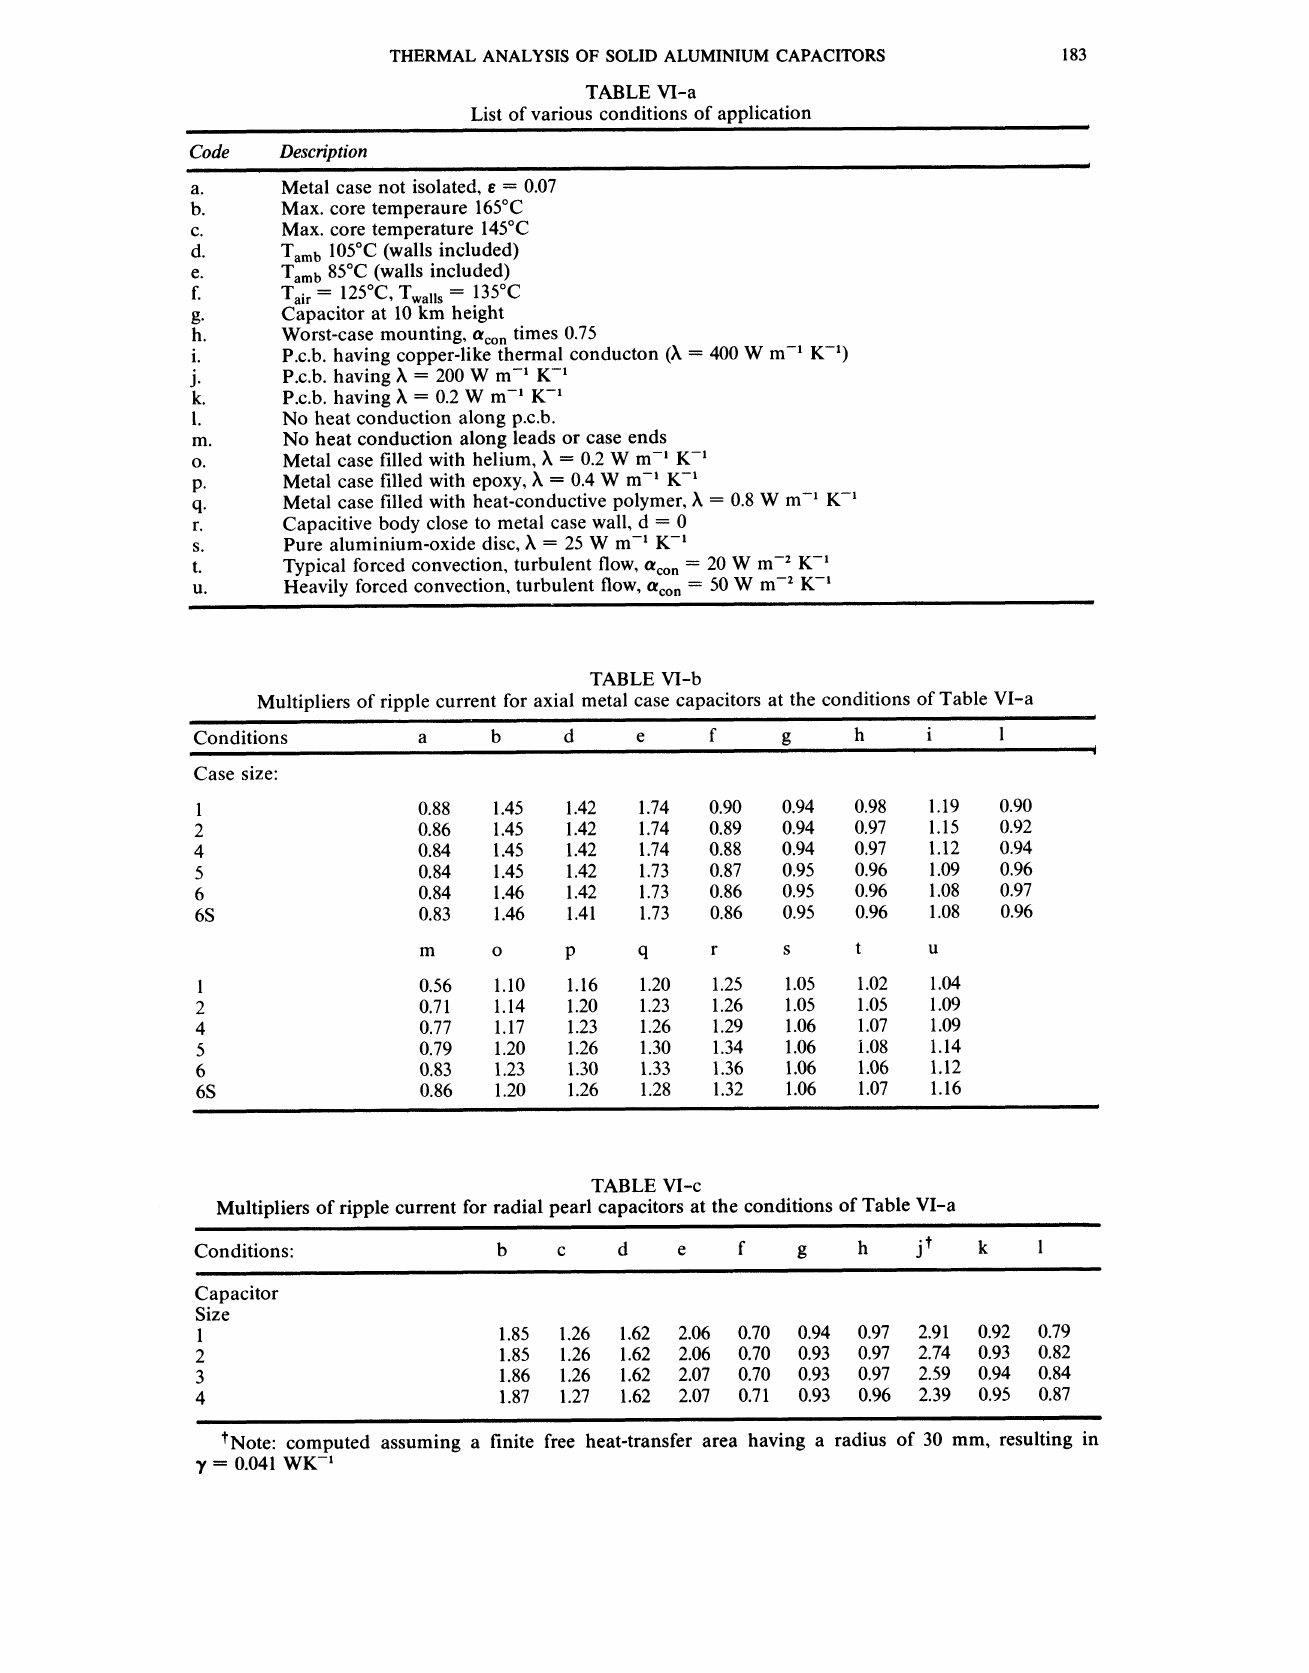
TABLE VI-a List of various conditions of application